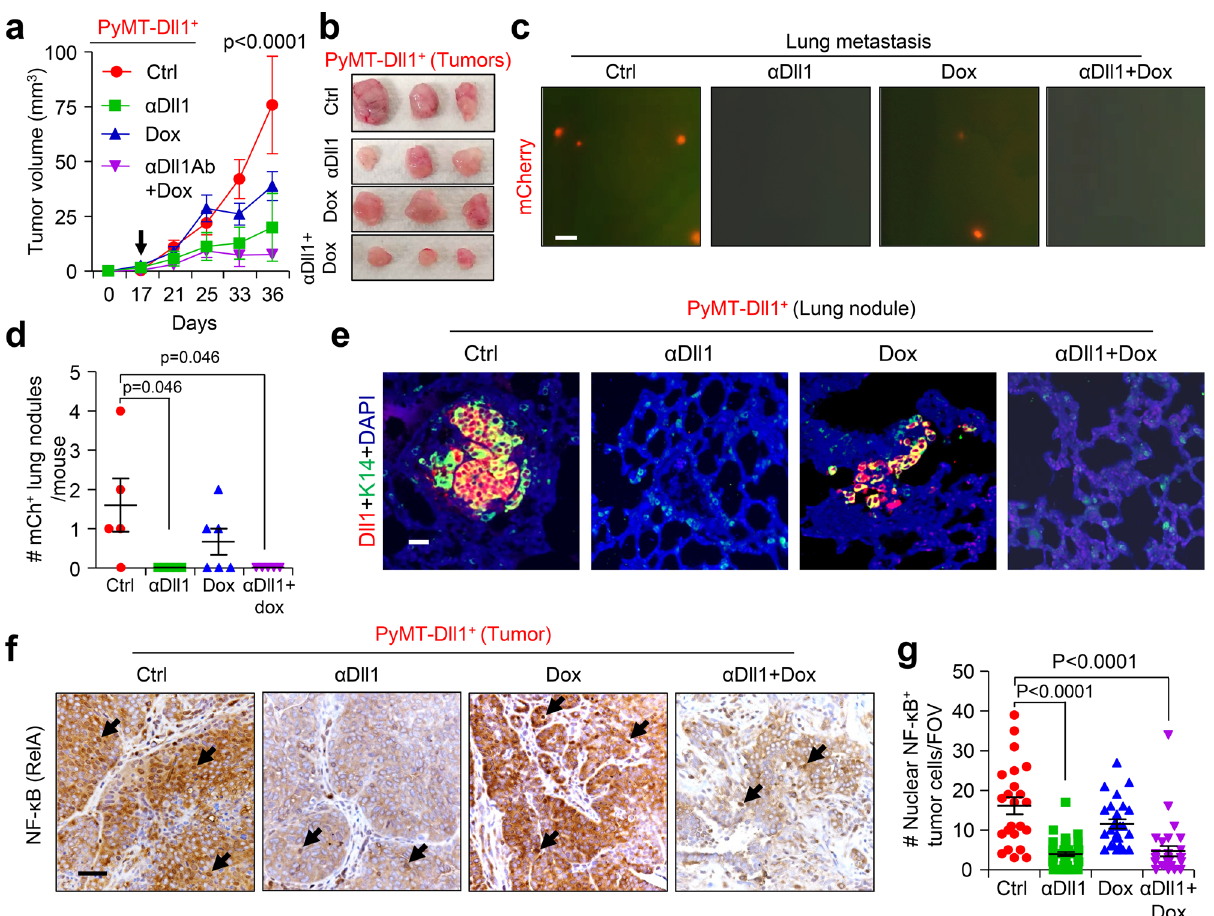
Fig. 6 The Dll1-blocking antibody treatment sensitizes the Dll1 + tumor cells to the chemotherapy. a, b Tumor growth curves a and representative whole tumor images ( b ) after Dll1 + tumor cells derived tumors were treated with indicated treatments (more details are in Supplementary Fig. 9a) ( n = 4 for ctrl, α Dll1 ab, and α Dll1 ab + Dox, n = 6 Dox tumors). The black arrow indicates the day when the treatments started. c – e Representative fl uorescence images show mCherry + nodules in whole lungs with quanti fi cation c , d . The scatter plot in d shows mCherry positive lung nodules, which were quanti fi ed under fl uorescent dissection microscope after harvest (data combined from two independent experiments, n = 5 Ctrl, n = 5 α Dll1 ab, n = 6 Dox, and n = 5 α Dll1 ab + Dox tumors). e Representative IF images of lung cross sections show presence of mCherry + cells (red). mCherry antibody was used to detect Dll1 mCh + cells. f , g The representative IHC images show the NF- κ B staining in Dll1 + tumors upon indicated in vivo treatments, which is quanti fi ed in g . The dots in scatter plot represents the FOVs, which is obtained from n = 3 tumors per group. FOV is fi eld of view. Black arrows indicate nuclear staining of NF- κ B in tumor cells. P values were calculated using two-way ANOVA with Bonferroni post-test adjustment a or one-way ANOVA with Tukey ’ s post-hoc test d , g . Data present three c, e or two f independent experiments. Data are presented as the mean±SEM. Scale bars, 200 µ m c , 20 µ m e and 60 µ m f . Source data are provided as a source data fi